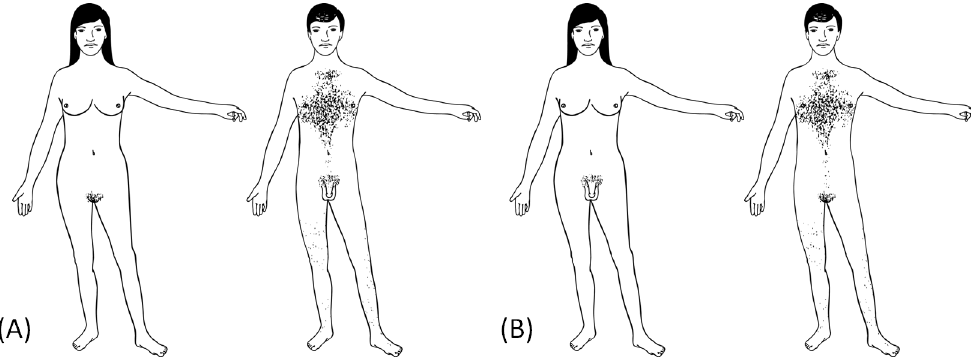
Fig 1. Stimuli in the congruent condition (A) and the incongruent condition